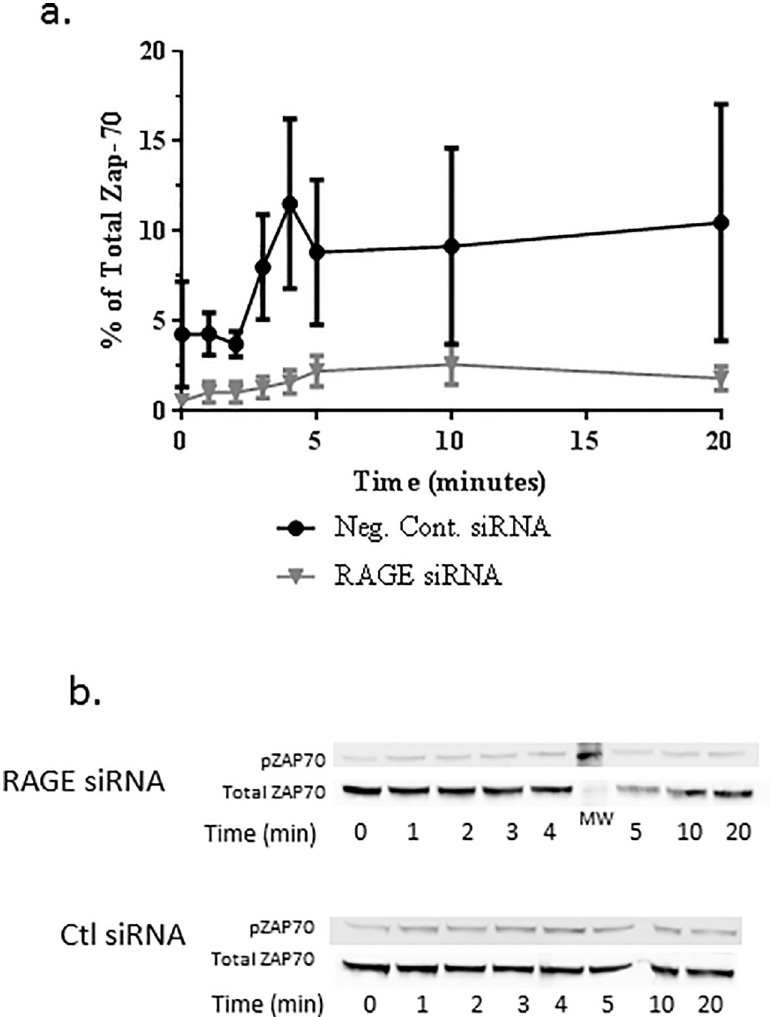
Fig 4. Inhibition of early activation events in Jurkat cells with RAGE siRNA. (a) 48 hours after transfection with the indicated siRNAs, Jurkat cells were stimulated with cross linked-OKT3 mAb for the indicated time and the levels of phosphorylated and total ZAP70 were determined by Western blot. The expression of pZAP70 were reduced in the RAGE siRNA treated cells. (n = 3 replicate studies, p = 0.0002 by a two-way ANOVA and the effects of the siRNAs were compared.) (b) A representative blot of total and pZAP70 are